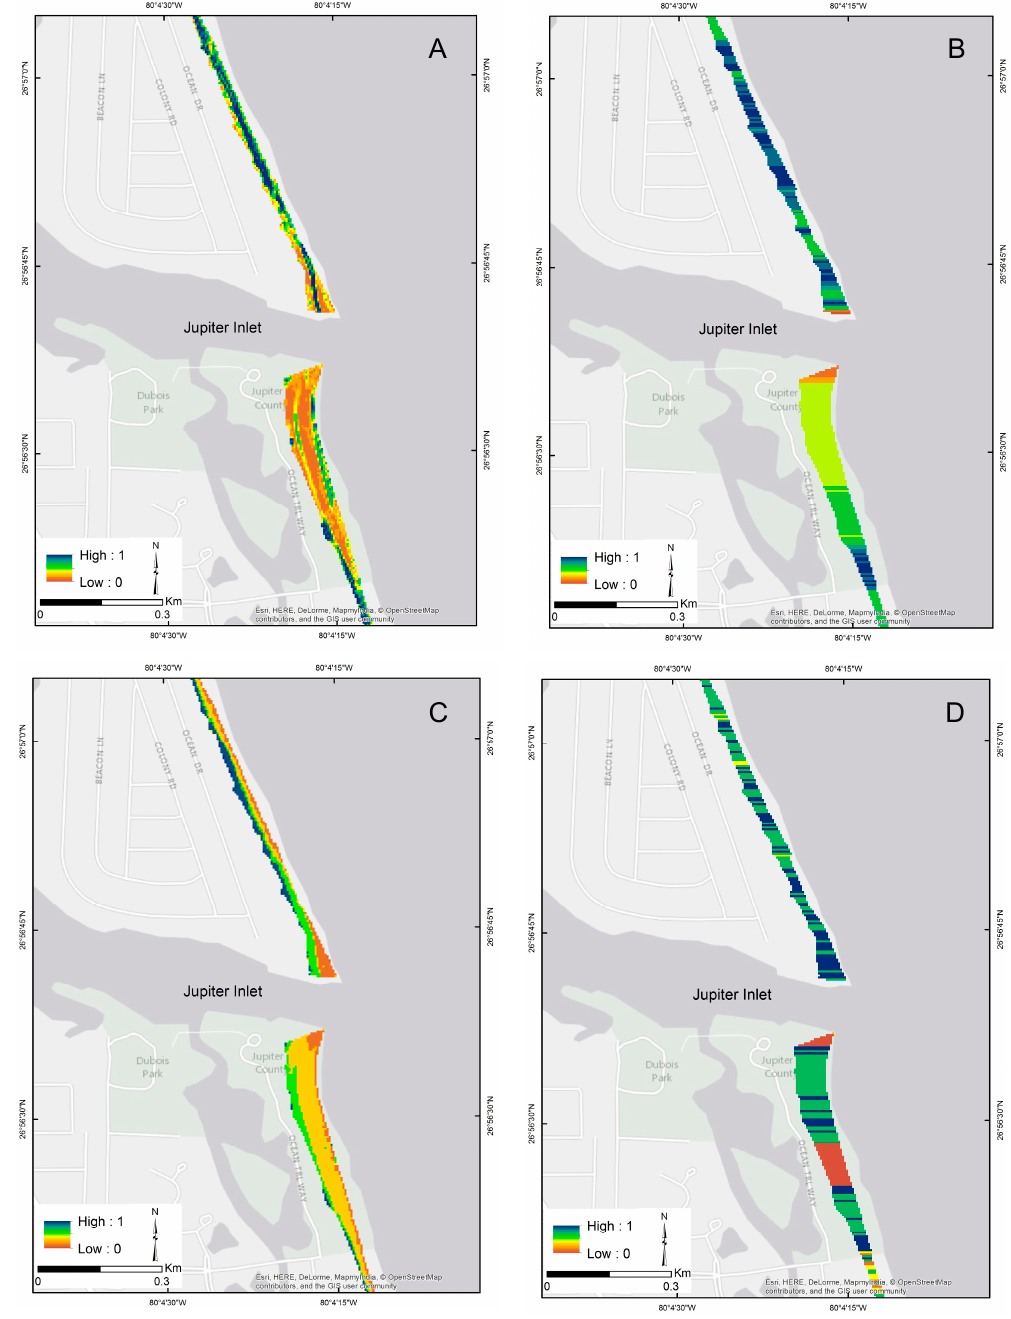
Figure 4. Rasterized model grids for: ( A ) slope; ( B ) beach width; ( C ) elevation; and ( D ) dune elevation for the area around Jupiter Inlet, FL.